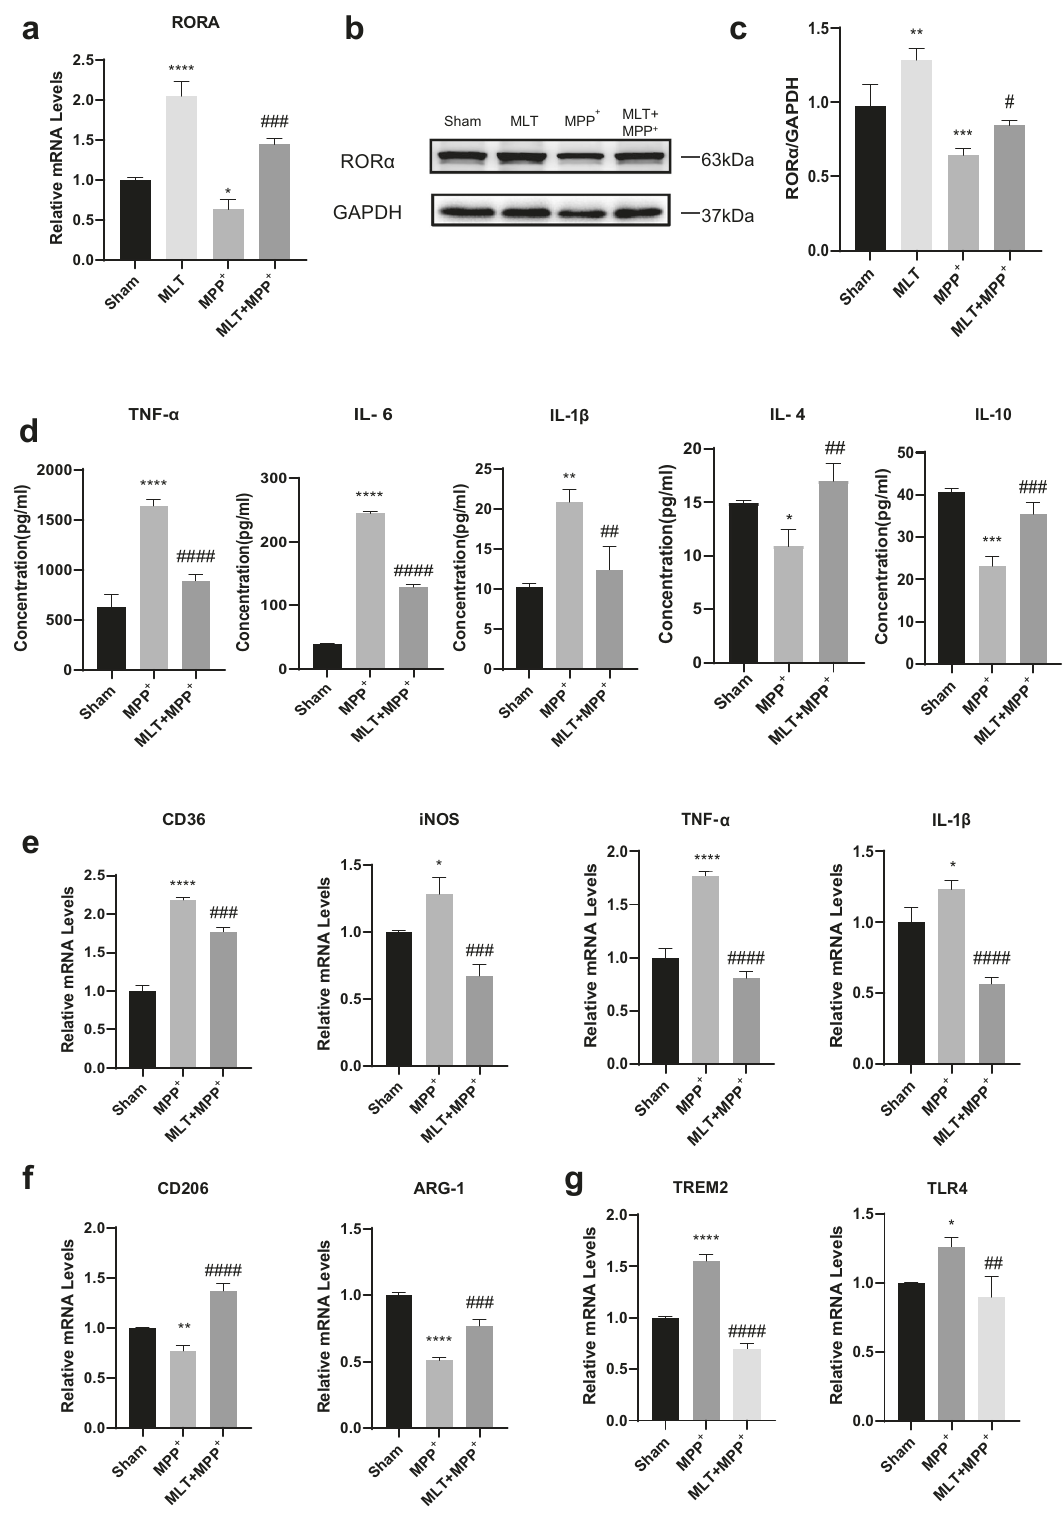
Fig. 2 MLT increased ROR α expression, inhibited pro-in fl ammatory M1-like microglial polarization and reduced neuroin fl ammation in vitro. BV2 cells were treated with MPP + (50 μ M), MLT (50 μ M) or pre-treated with MLT half an hour before MPP + , and then incubated for 24 h. a Relative mRNA levels of ROR α in different groups were determined by RT-qPCR. b , c Immunoblot analysis of ROR α . Protein levels were normalized to GAPDH. d ELISA results showed the culture medium levels of IL-6, TNF- α , IL-1 β , IL-4, and IL-10. e mRNA quanti fi cation of pro- in fl ammatory (M1-like) phenotype markers (CD36, iNOS, TNF- α , IL-1 β ) in BV2 cells by RT-qPCR. f mRNA quanti fi cation of anti-in fl ammatory (M2-like) phenotype markers (CD206, ARG ‐ 1) in BV2 cells. g mRNA quanti fi cation of DAM phenotype markers (TREM2, TLR4) in BV2 cells. Data were average with error bars representing standard deviation. ( n = 3 independent experiments. *, # P < 0.05; **; ## P < 0.01; ***, ### P < 0.001; ****, #### P < 0.0001; *, vs Sham group; #, vs MPP +